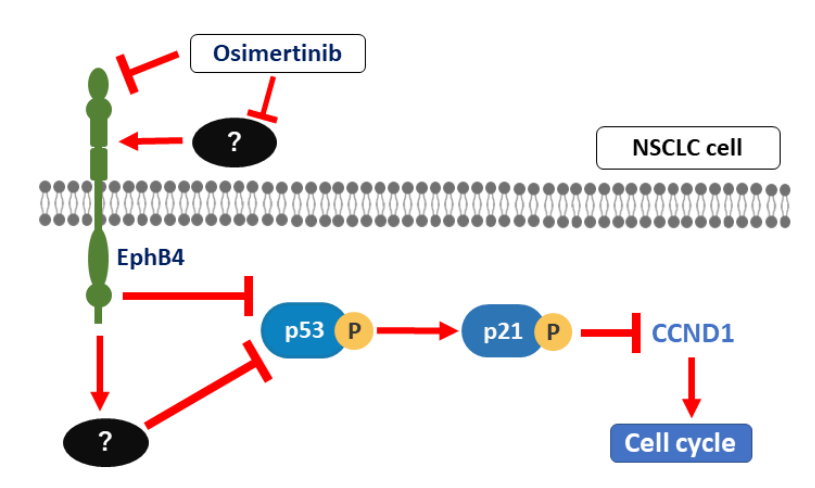
Figure 6. The outline of our hypothesis regarding the signal pathway of the anti-cancer effect of osimertinib via EphB4. Osimertinib may be involved in the suppression of cell proliferation via the EphB4 and p53-p21-Cyclin D1 pathway independent of the EGFR pathway in NSCLC